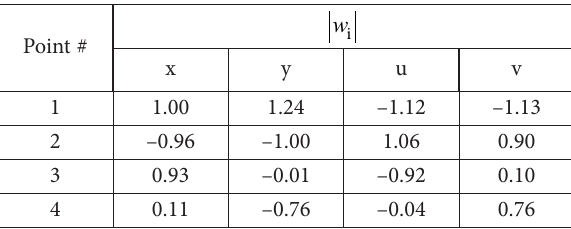
Table 4. The absolute value of the test statistic w i for each of the measurements